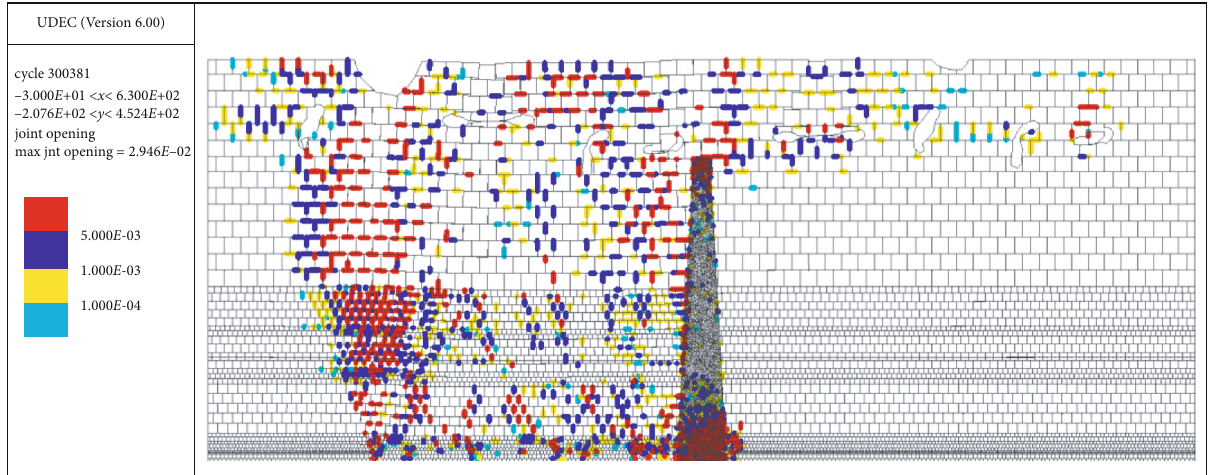
Figure 8: The mining-induced fracture fi eld (the mining distance is